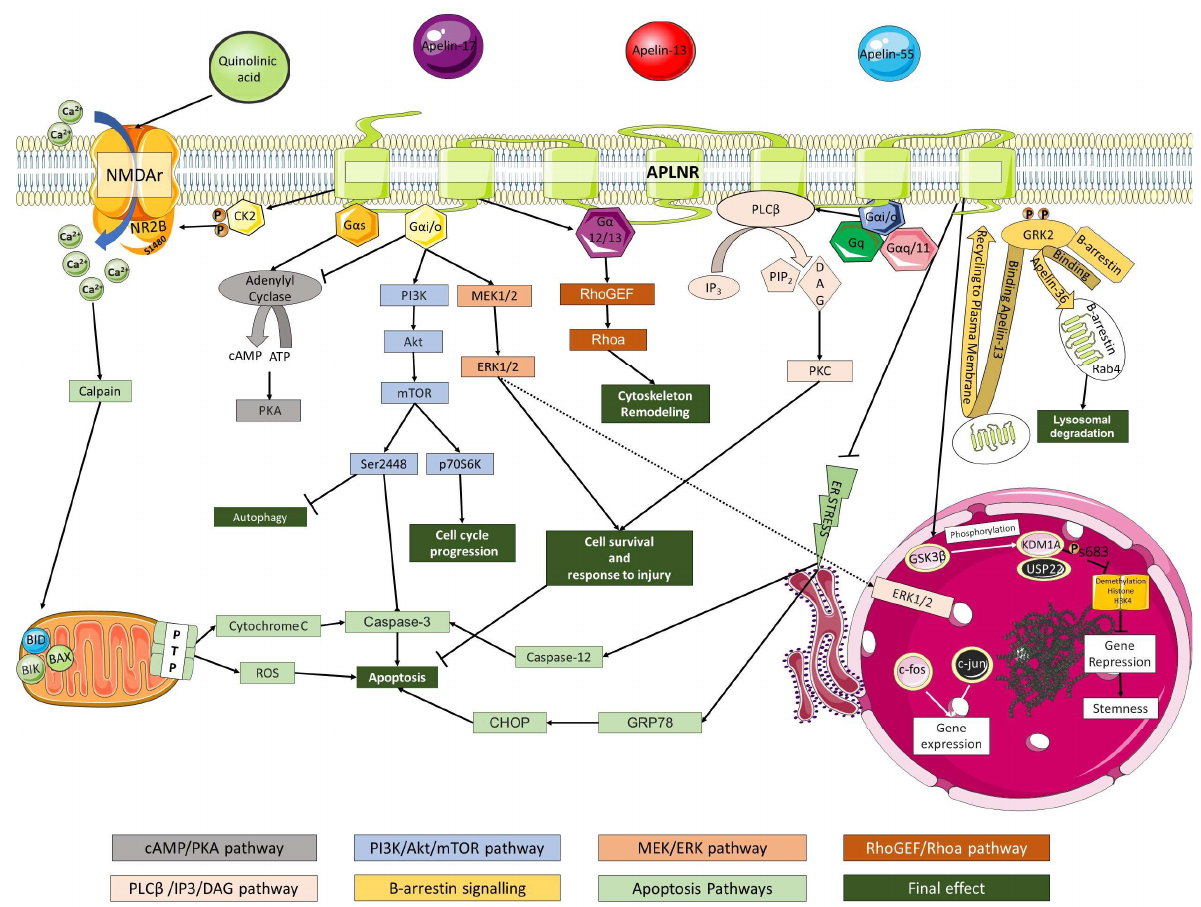
Figure 2. Signaling pathways associated with activation of APLNR.